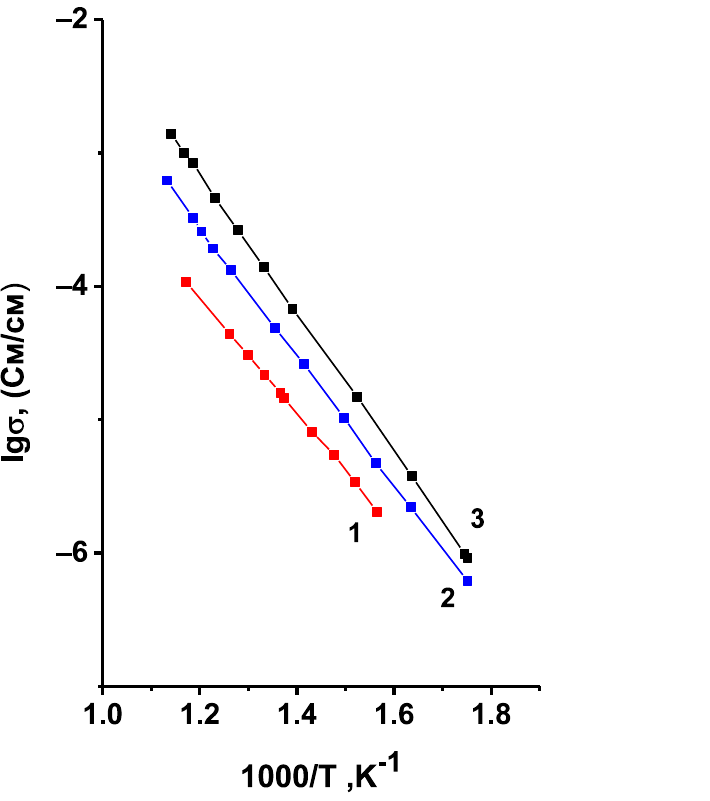
Figure 6. Temperature dependences of conductivity for Li 6 Zr 2 O 7 samples synthesized at 850 °C (1), 900 °C (2), 950 °C (3).